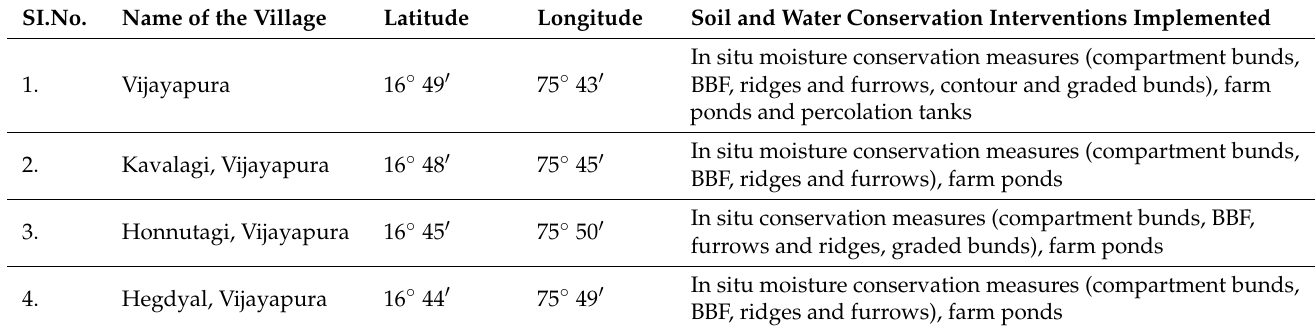
Table 6. Validation of different in situ interventions in different villages of northern dry zone of